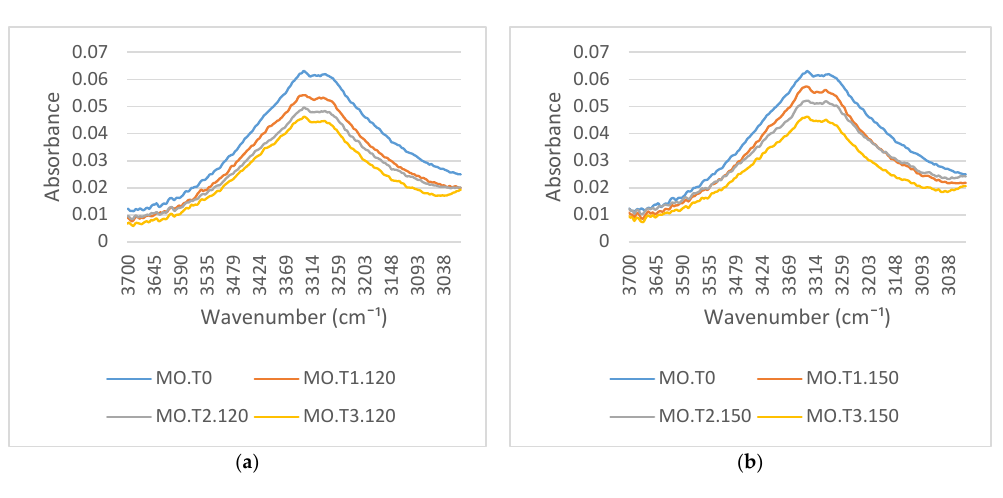
Figure 4. FTIR spectra at 3700–3000 cm − 1 of transformer paper aged in mineral oil at aging temperatures of ( a ) 120 °C and ( b ) 150 °C.